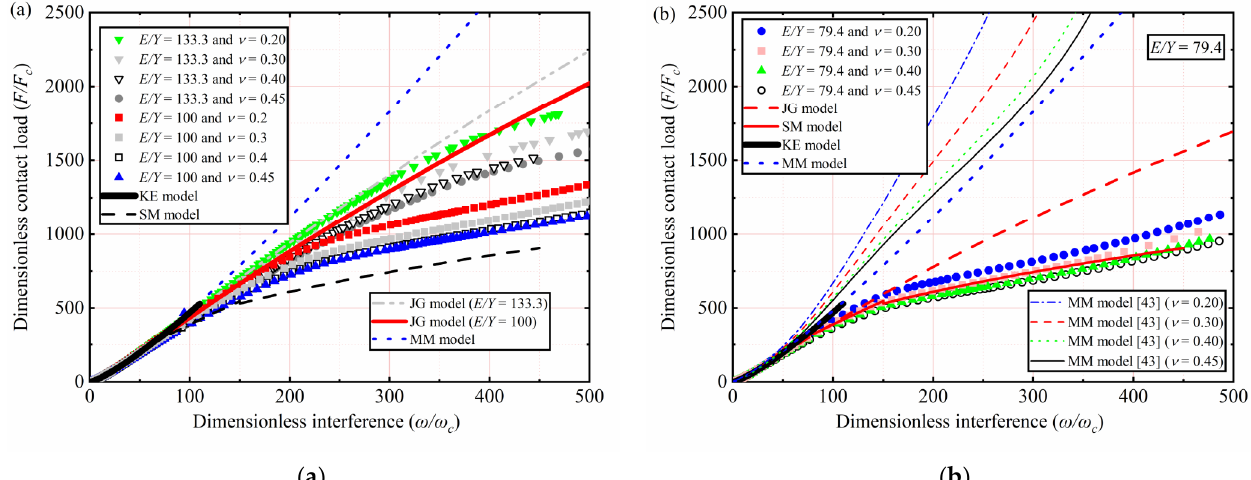
Figure 6. F / F c as a function of ω / ω c for different Y , ν , and E / Y ≤ 133.3: ( a ) E / Y = 133.3 and E / Y = 100; ( b ) E / Y = 79.4.